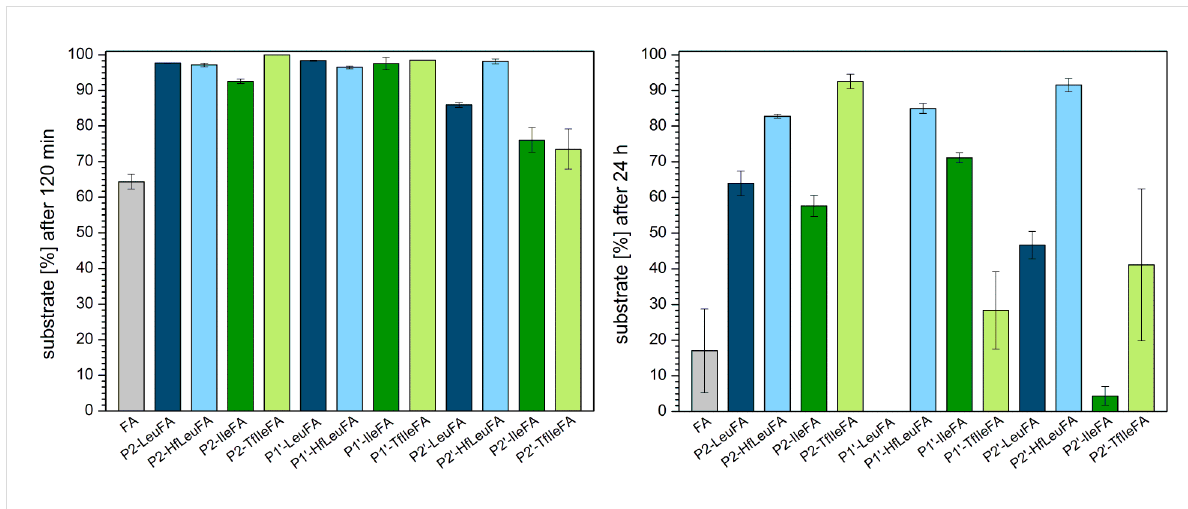
Figure 6: Percentage of substrate remaining after incubation for 120 min (left) and 24 h (right) with elastase in 100 mM Tris/HCl buffer, pH 8.4, at 37 °C. The data shown represent the mean of three independent measurements. Errors are derived from the standard deviation.